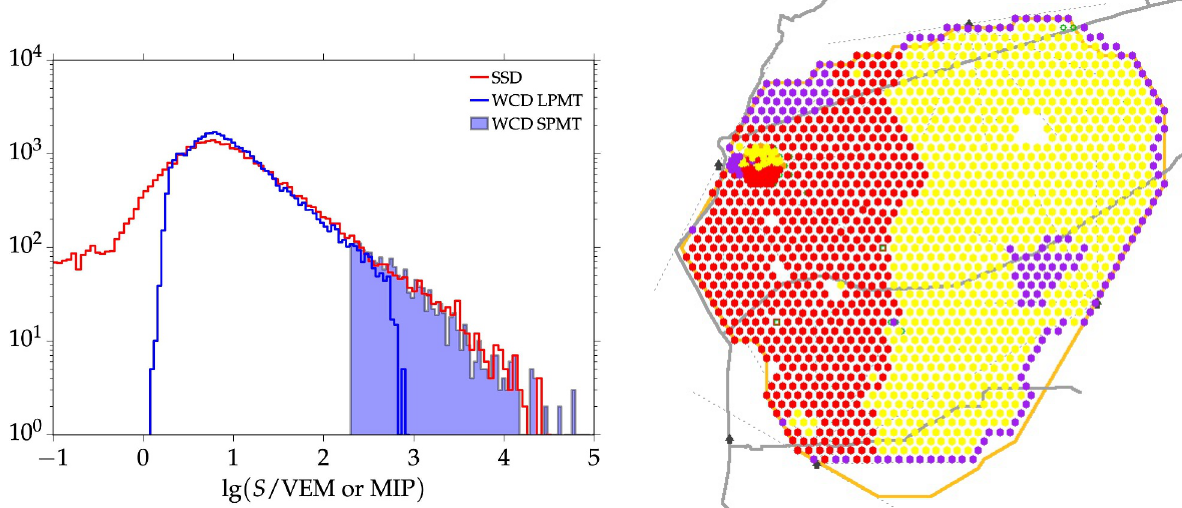
Figure 3. Left: The dynamic range of both WCD (blue) and SSD (red). The extension of the WCD dynamic range is obtained thanks to the SPMT. Right: map showing the status of the AugerPrime deployment on 03 / 10 / 2022. Red dots: WCD + SSD + UUB stations (except on the border) ; yellow dots: WCD + SSD; purple dots: WCD